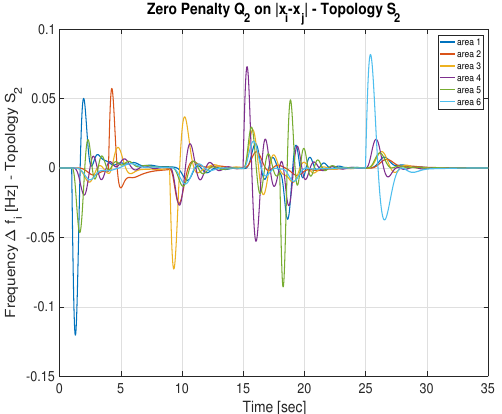
Figure 13. Frequency deviation ∆ f i response for i = 1, · · · ,6, topology S 2 , control tuning with Q 2 = 0, uncertain parameters.